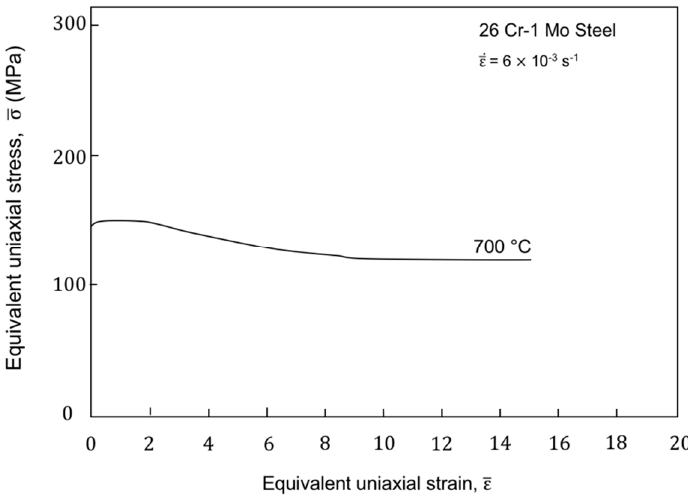
Figure 5. The torsion stress versus strain behavior of a 26Cr-1Mo ferritic stainless steel [7] at 700 °C (approximately 0.55 T m ).